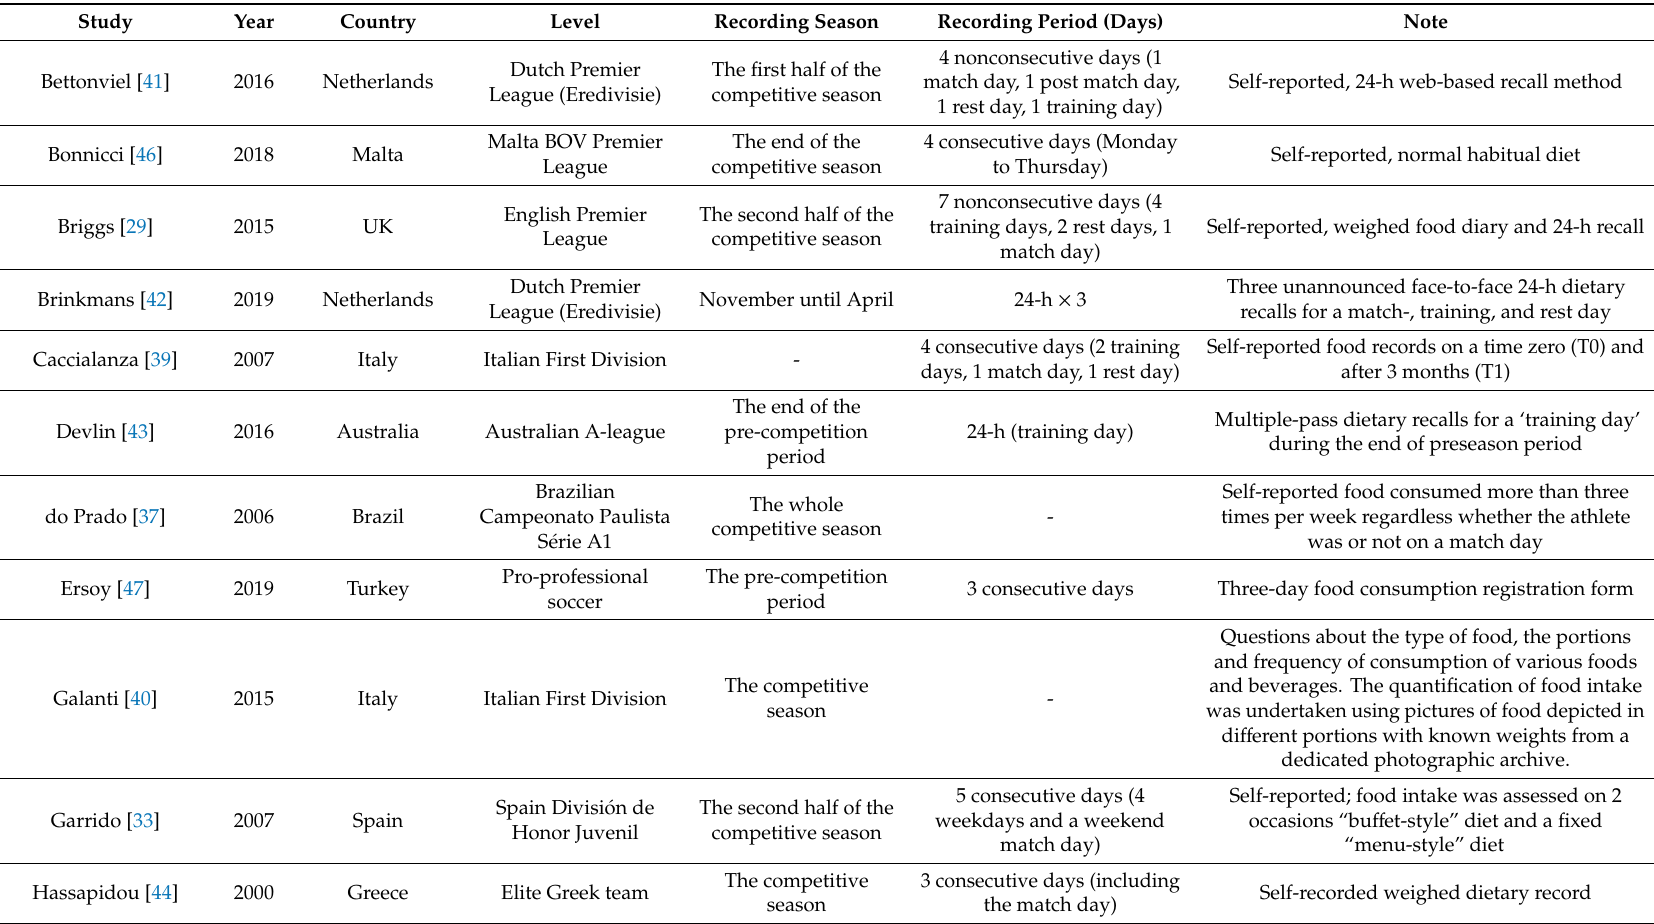
Table 2. Descriptive information of the studies included in the